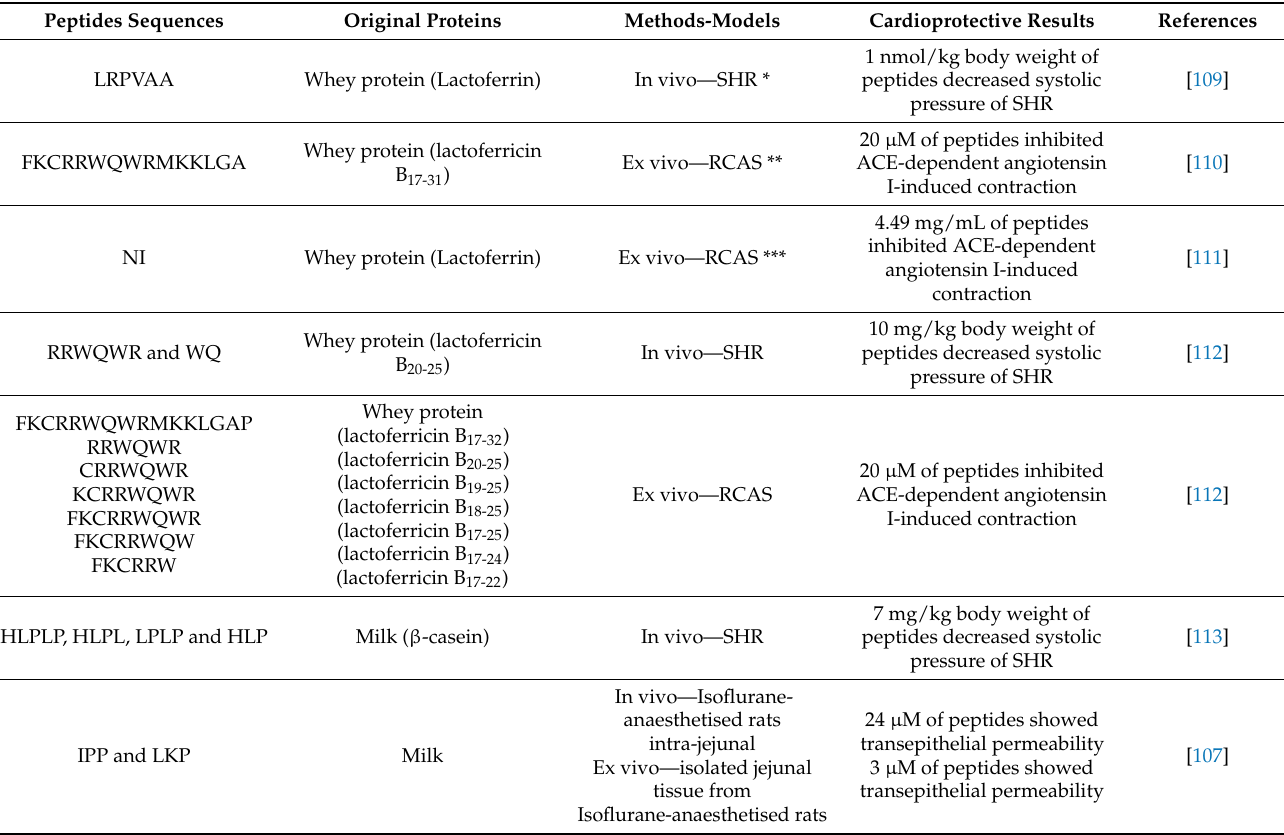
Table 4. In vivo and ex vivo studies assessing cardioprotective properties of peptides from dairy. Peptides Sequences Original Proteins Methods-Models Cardioprotective